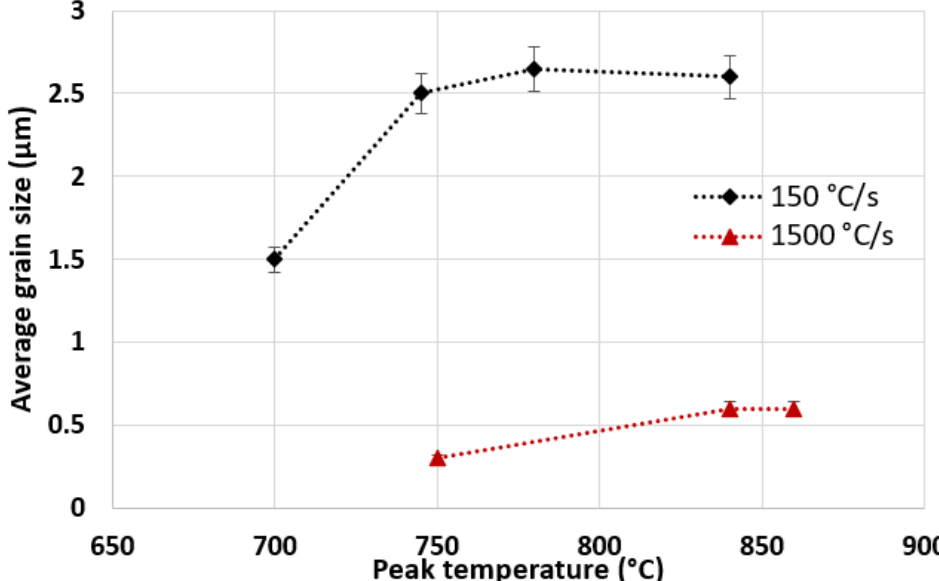
Figure 3. Ferritic grain size variation as function of temperature for the heating rates of 150 and 1500 °C/s (data from [42]).